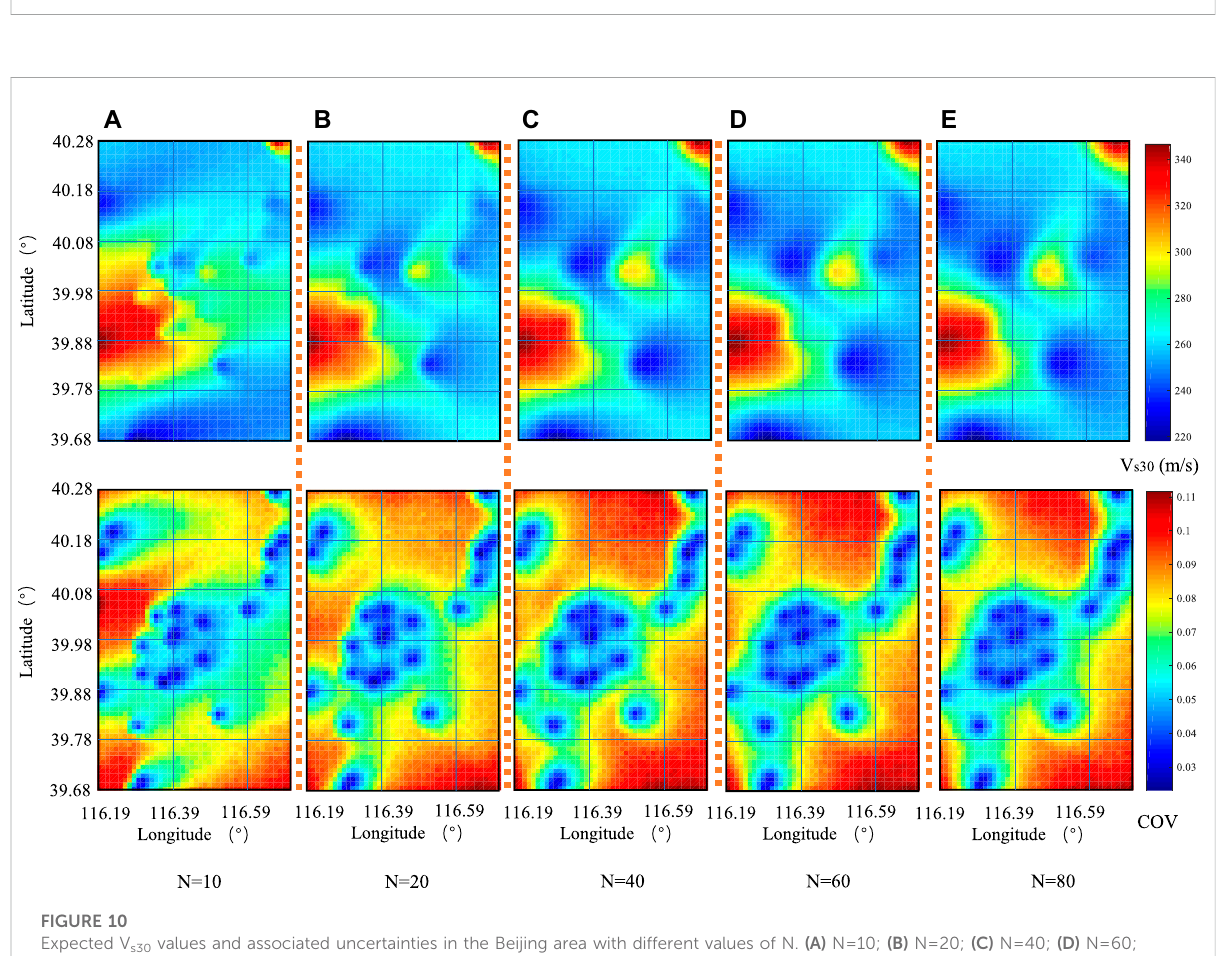
Comparison between IDW and Random fi eld model: (A) V s30 realizations calculated by IDW; (B) Comparison of results between two methods.